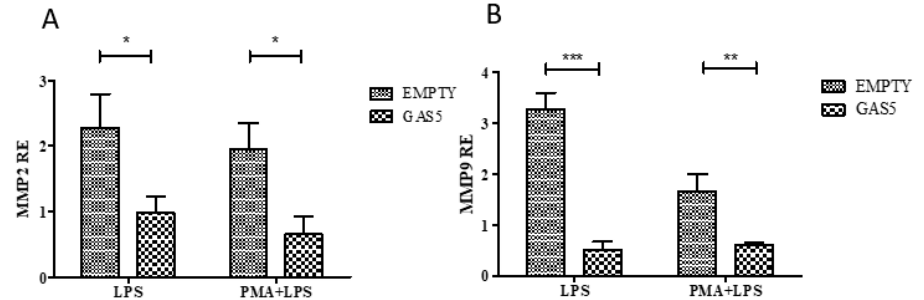
Figure 7. Levels of MMP2 ( A ) and MMP9 ( B ) after overexpression of GAS5 (GAS5) in monocyte stimulated with LPS (LPS) and macrophages stimulated with LPS (PMA + LPS) and in controls (EMPTY). MMP2 and MMP9 expression were normalized using GAPDH gene and relative expression (RE) values are expressed as 2 − ∆∆ Ct . Two-way ANOVA: EMPTY vs. GAS5 MMP2 p = 0.002, MMP9 p < 0.0001 Bonferroni’s multiple comparison post-test * p < 0.05, ** p < 0.01, *** p < 0.001. 2.6. MMP2 and MMP9 Proteins Released by THP1 Cells Overexpressing GAS5